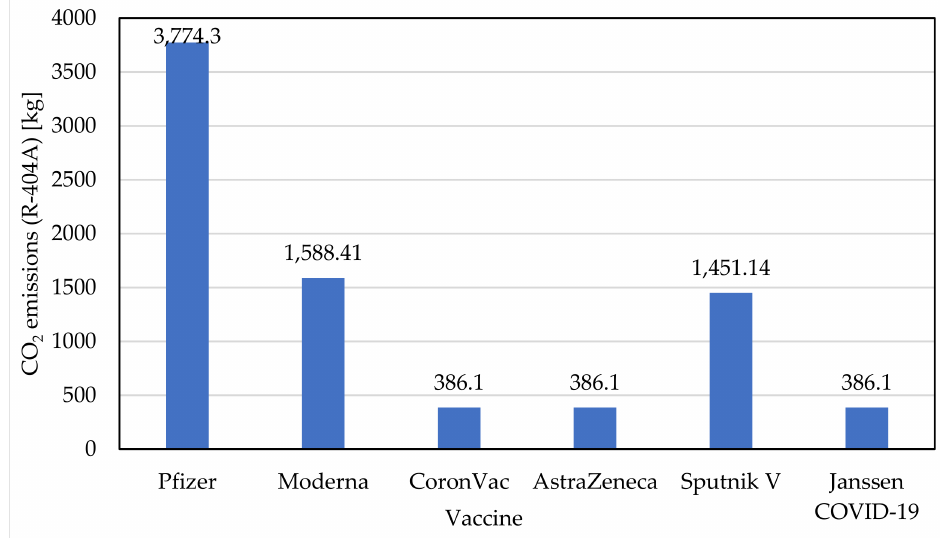
Figure 1. Environmental impact in terms of CO 2 emissions, assuming the use of R-404A initial refrigerant load.